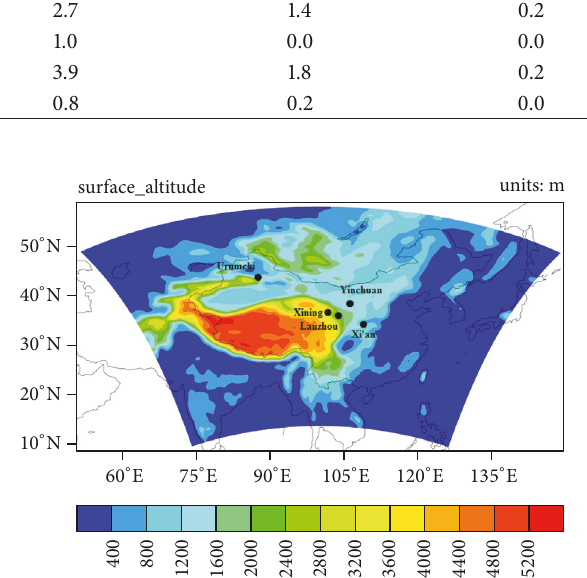
Figure 2: The five stations in provincial capital cities, as presented in Table 2 (black points), and the domain of the RegCM4 simulation. Shading denotes surface model elevation